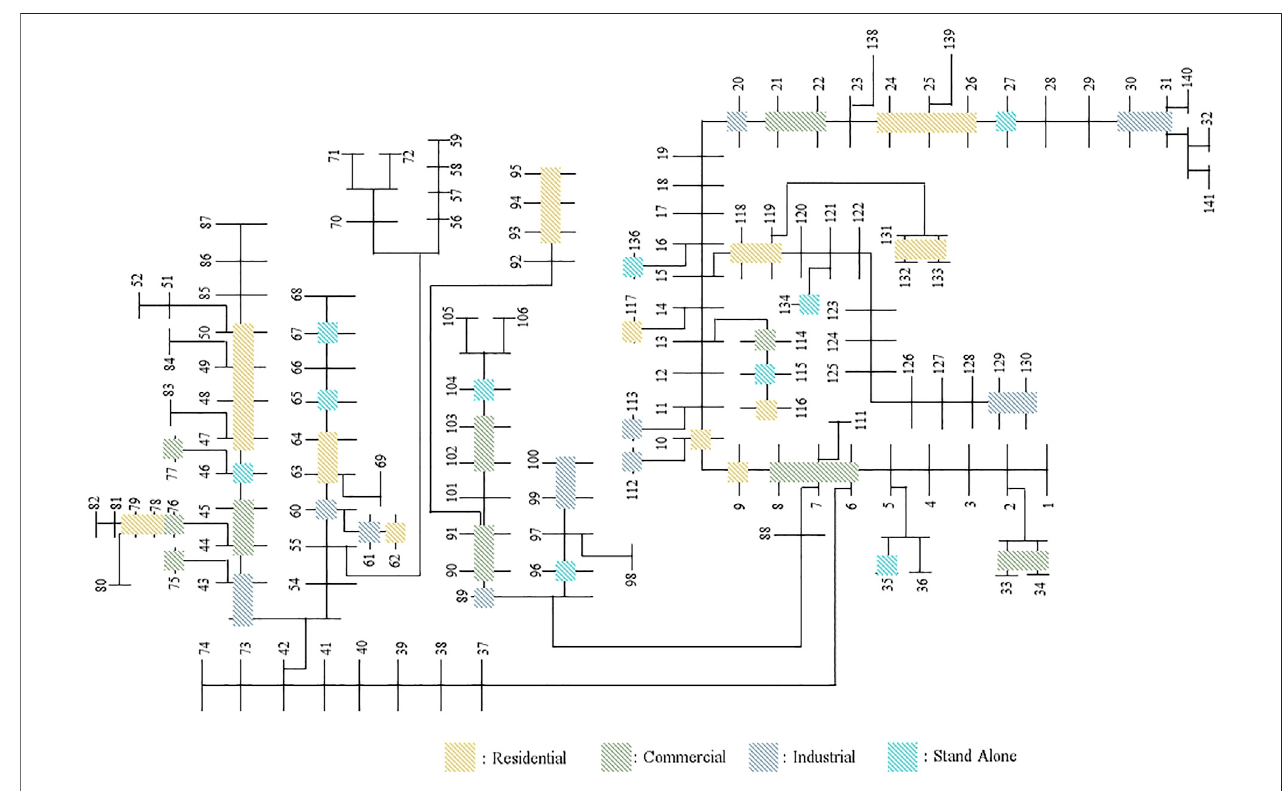
FIGURE 11 | Con fi guration of 141-bus distribution system with prosumers.